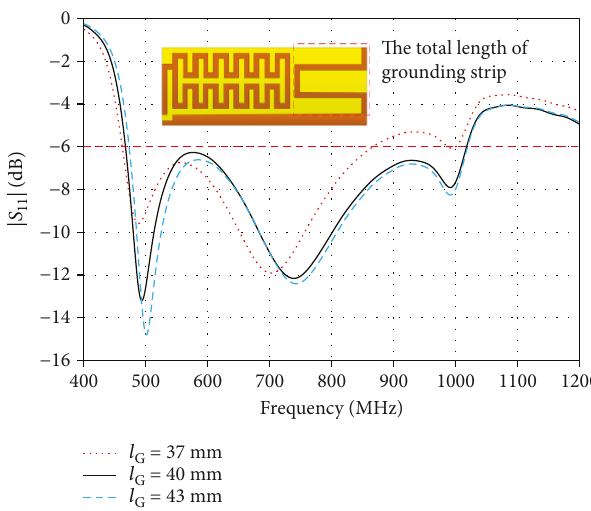
| of the proposed MD-loaded MLA for 11